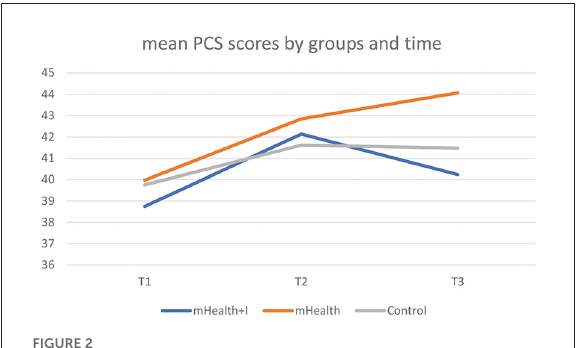
FIGURE2 Mean PCS scores by three groups and time.